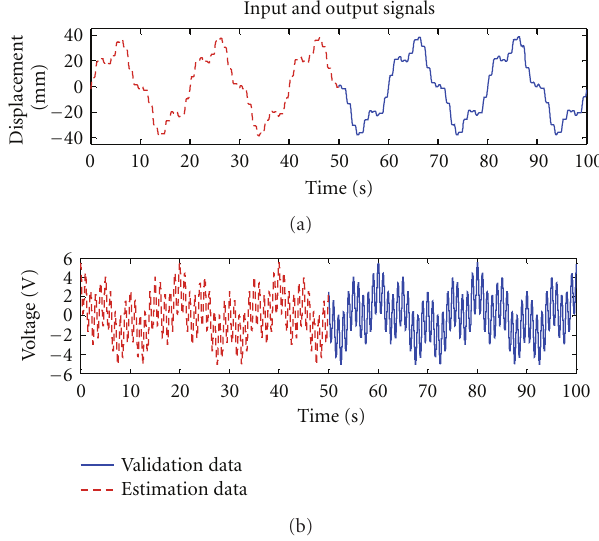
Figure 2: Input-output signals for system